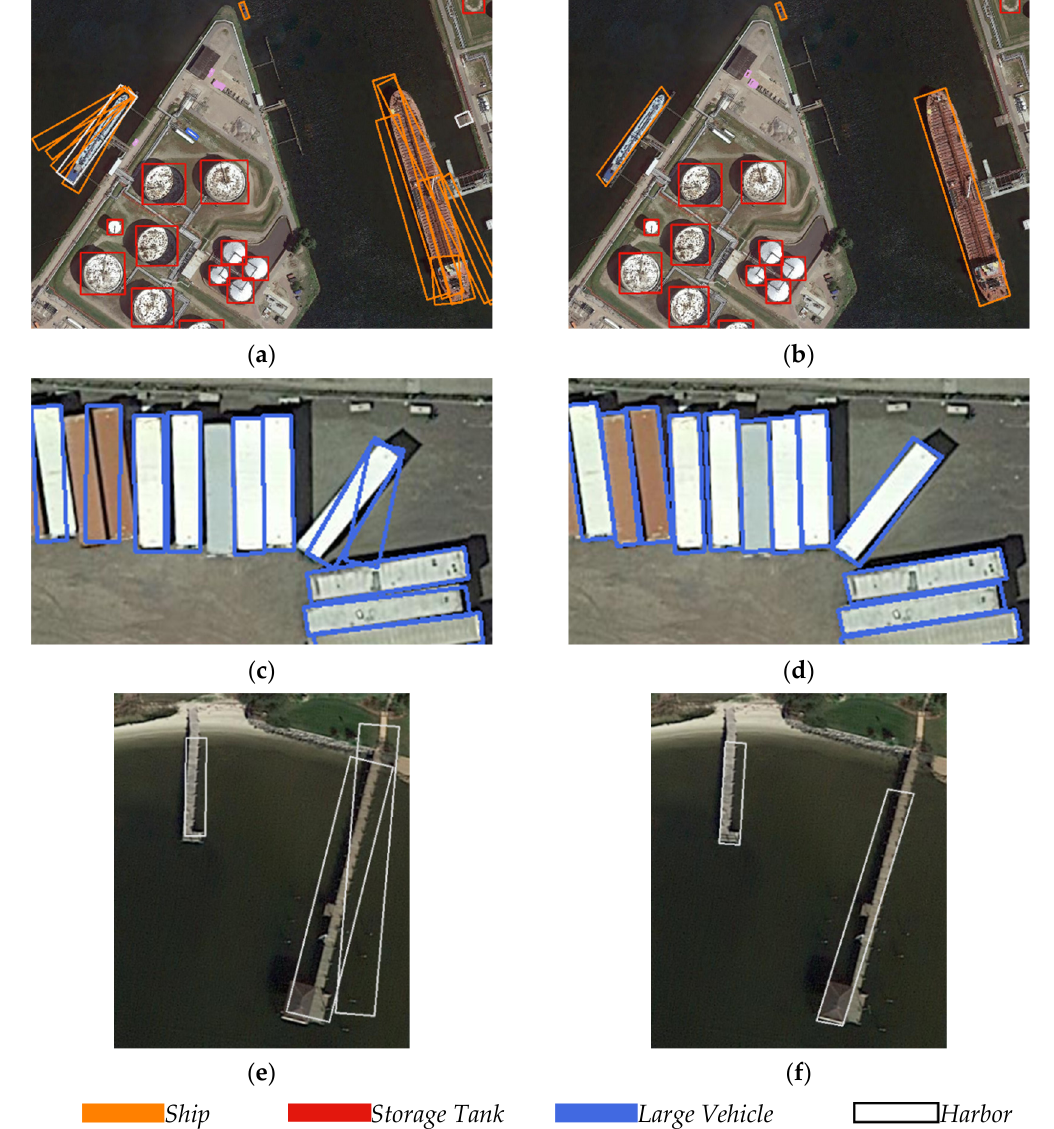
Figure 11. Comparison of R2CNN and TPR-R2CNN detection result (the threshold of score is 0.5). ( a , b ) ship, storage tank; ( c , d ) large vehicle; and ( e , f ) harbor.